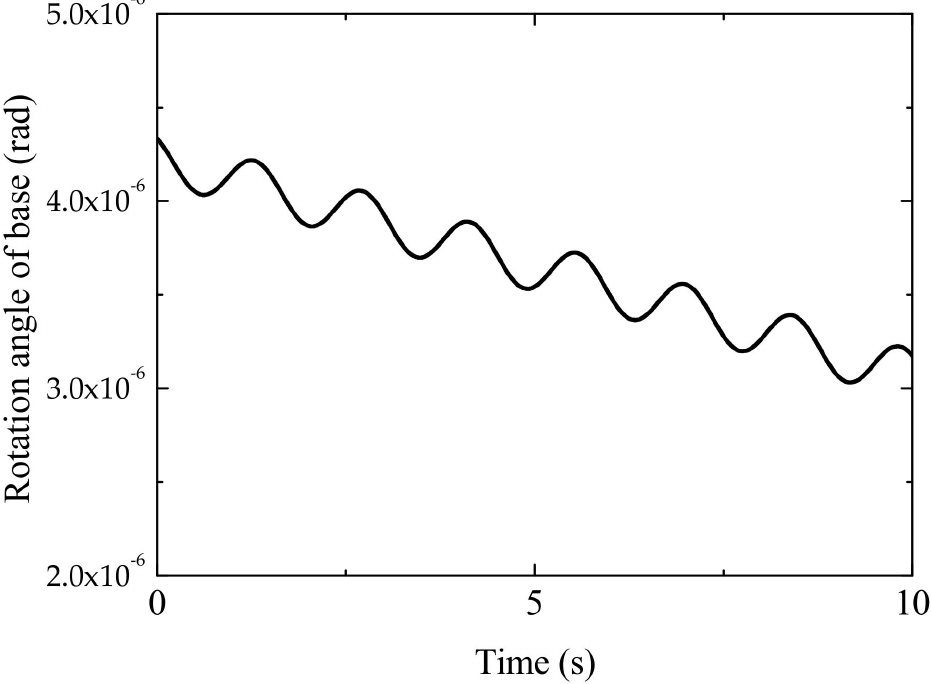
Figure 22. Rotation angle of the base in the trajectory tracking stage.